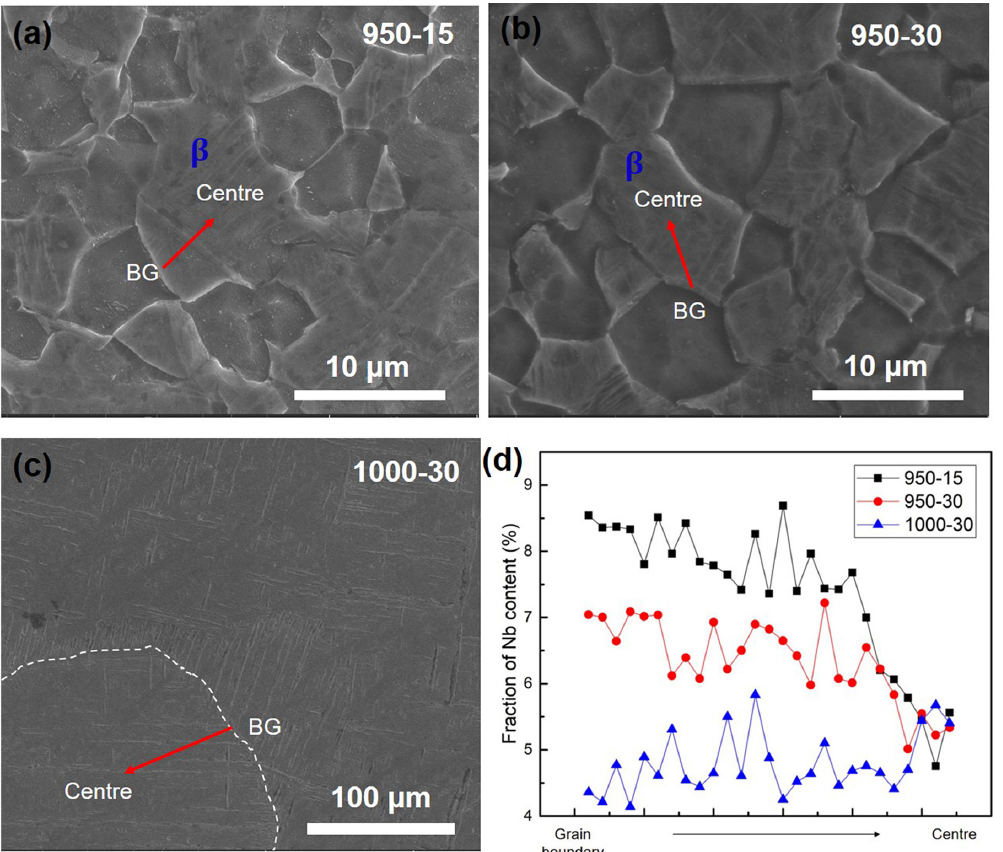
Figure 7. The regions of line scanning of (a) sample 950-15, (b) sample 950-30 and sample 1000-30, and (d) the linear composition analysis of Nb content of in samples 950-15, 950-30 and